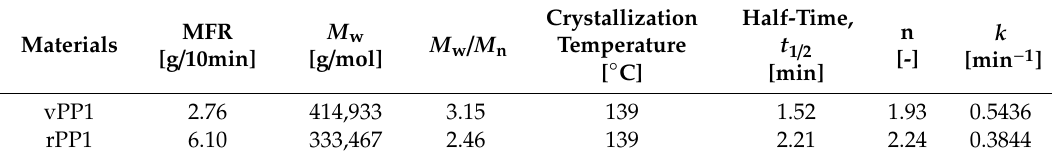
Table 2. Weight average molecular weight ( M w ), molecular weight distribution ( M w / M n) and